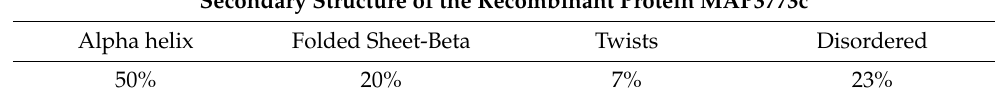
Figure 6. Secondary structure studies of MAP3773c. ( a ) Spectrum generated by circular dichroism analysis of MAP3773c recombinant protein from 195 nm to 265 nm. ( b ) Secondary structure prediction from MAP3773c protein. Data were obtained using the PSIPRED web server (http://bioinf.cs.ucl.ac.uk/psipred/, accessed on 12 July 2016). Table 1. Interpretation of the circular dichroism analysis performed on the recombinant MAP3773c protein.